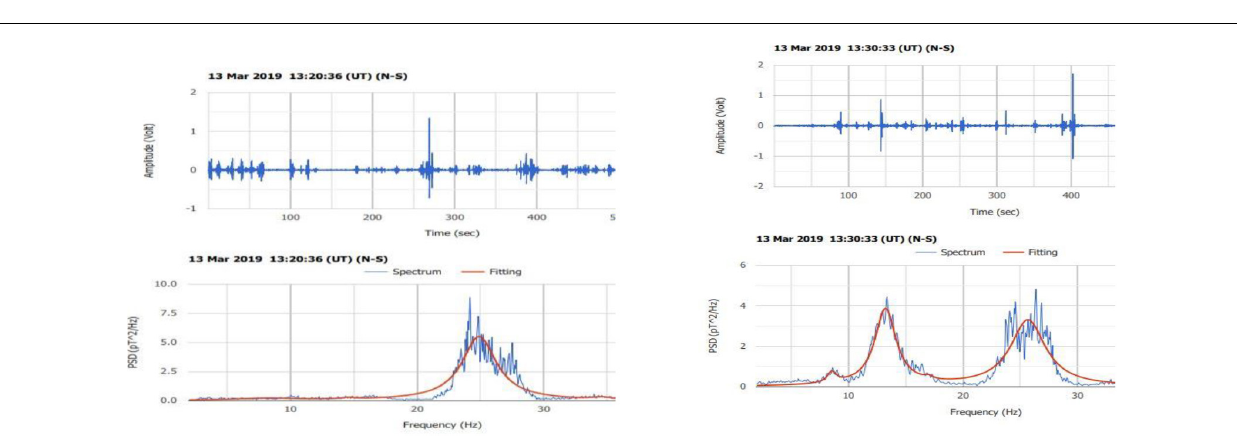
Frontiers in Earth Science |